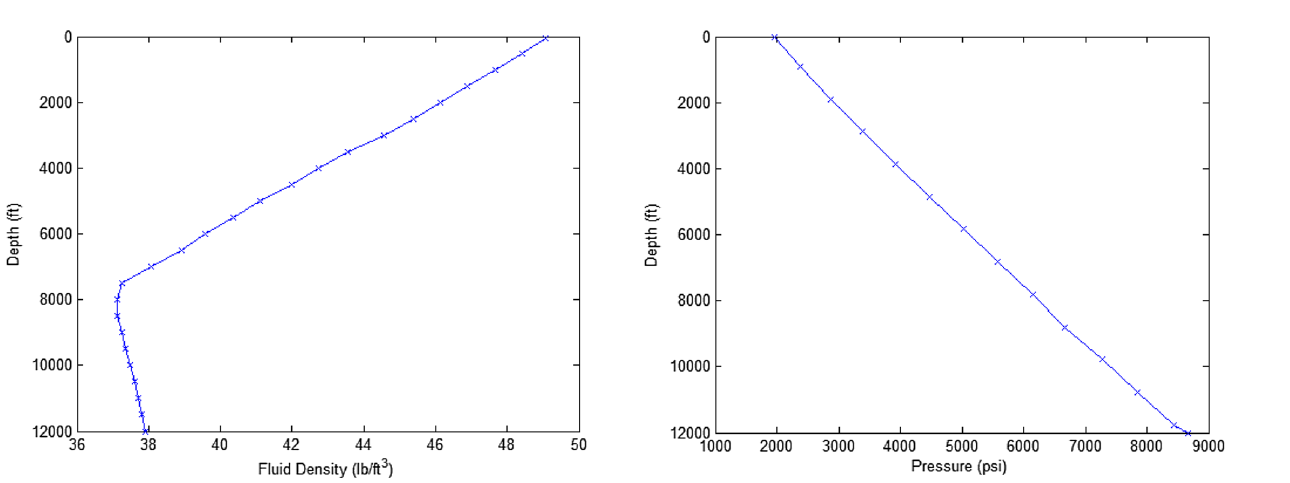
Fig. 9 Pressure profile in the well for choke size of 44/64 inches